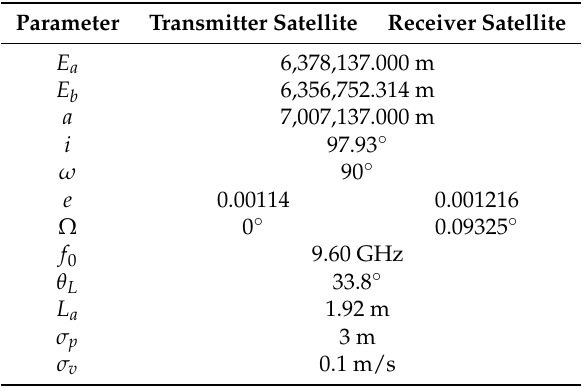
Table 1. Simulation